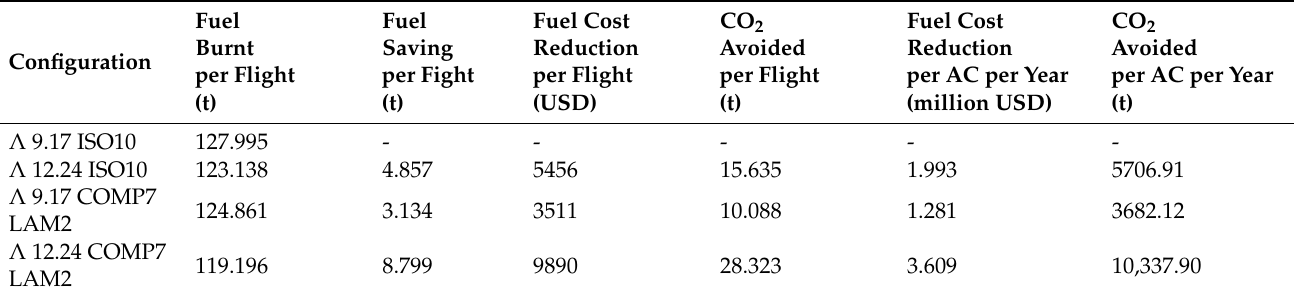
Table 10. Environmental and economic impact quantitative analysis: comparison between the baseline aluminum configuration, the same Λ but realized with composite materials and the most promising composite solution with Λ = 12.24. A 10,000 km route is